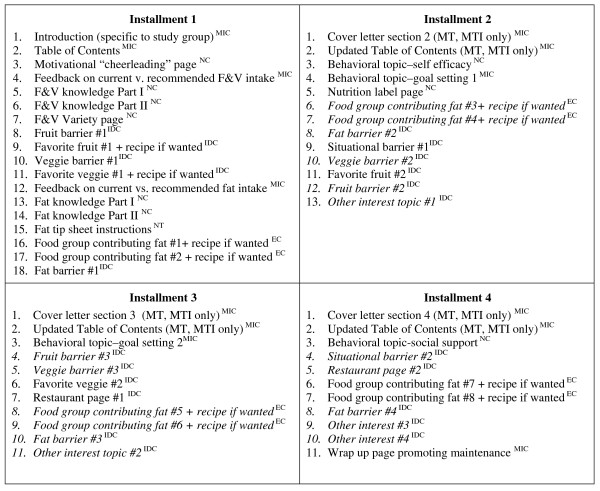
Tailored content included in each installment of YHL-SVS intervention materials.